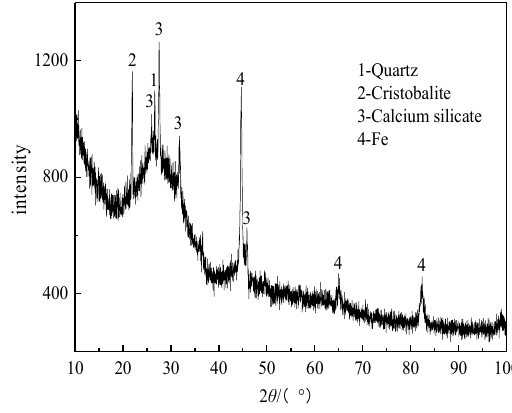
Figure 4. XRD pattern of the roasted product.